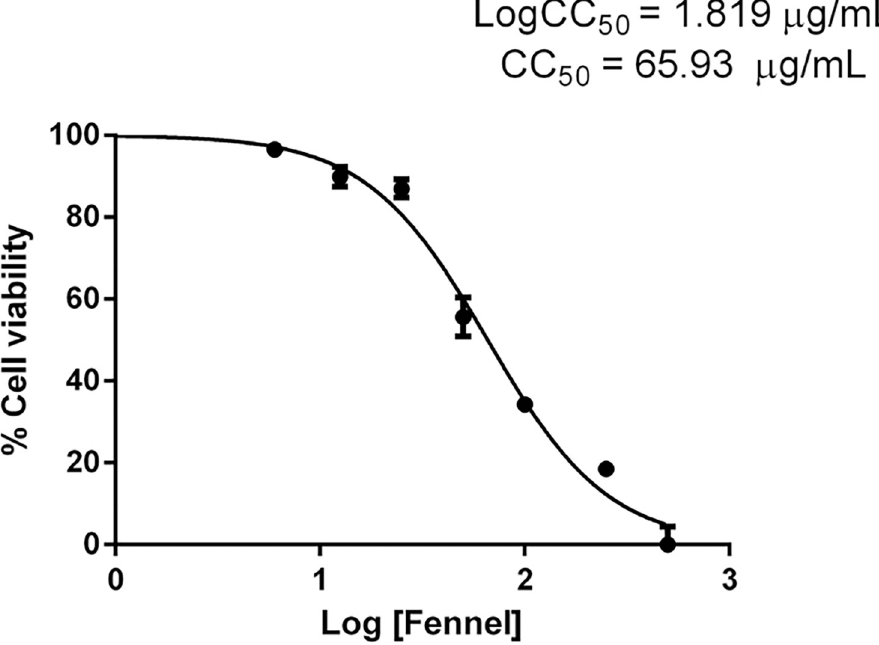
Fig 5. Cell viability and CC 50 . MTT assay showing the AGS cells viability after incubation with increasing concentrations of HS-FEN (spanning from 6 μ g mL -1 to 500 μ g mL -1 ) for 24 hours. The concentration of 65.93 μ g/mL was estimated as that inhibiting 50% of cell viability (CC 50